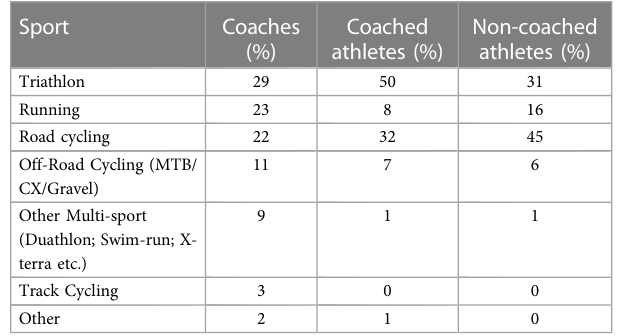
TABLE 3 Main sport of participants.